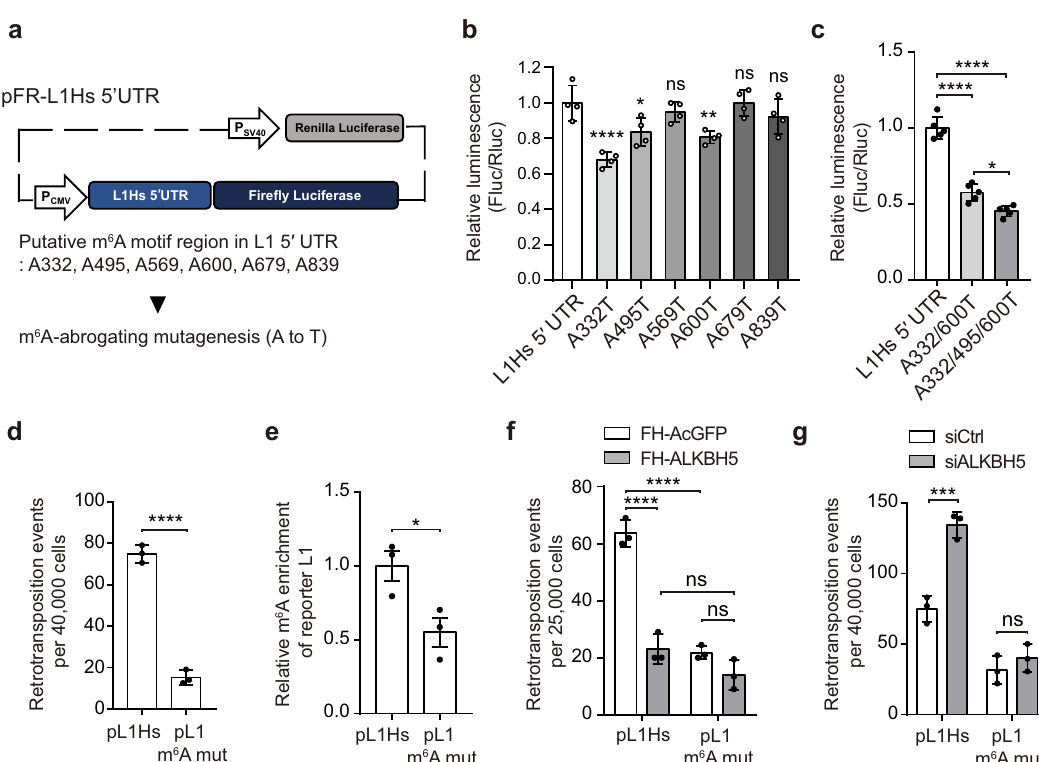
Fig. 3 L1 5 ′ UTR m 6 A cluster promotes L1 activity. a Schematic of the dual-luciferase plasmid carrying L1 5 ′ UTR upstream of the fi re fl y luciferase gene (pFR-L1Hs 5 ′ UTR). Fire fl y luciferase luminescence re fl ected the effect of 5 ′ UTR and of its mutations. b , c Dual-luciferase assay using HeLa cells transfected with pFR-L1Hs 5 ′ UTR or its A to T m 6 A-abrogating mutant. The ratio of the luminescence of fi re fl y and Renilla luciferase (Fluc/Rluc) was normalized to pFR-L1Hs 5 ′ UTR-expressing cells. (mean ± s.d., four ( b ) or fi ve ( c ) independent samples). d L1 assays using the triple m 6 A mutated